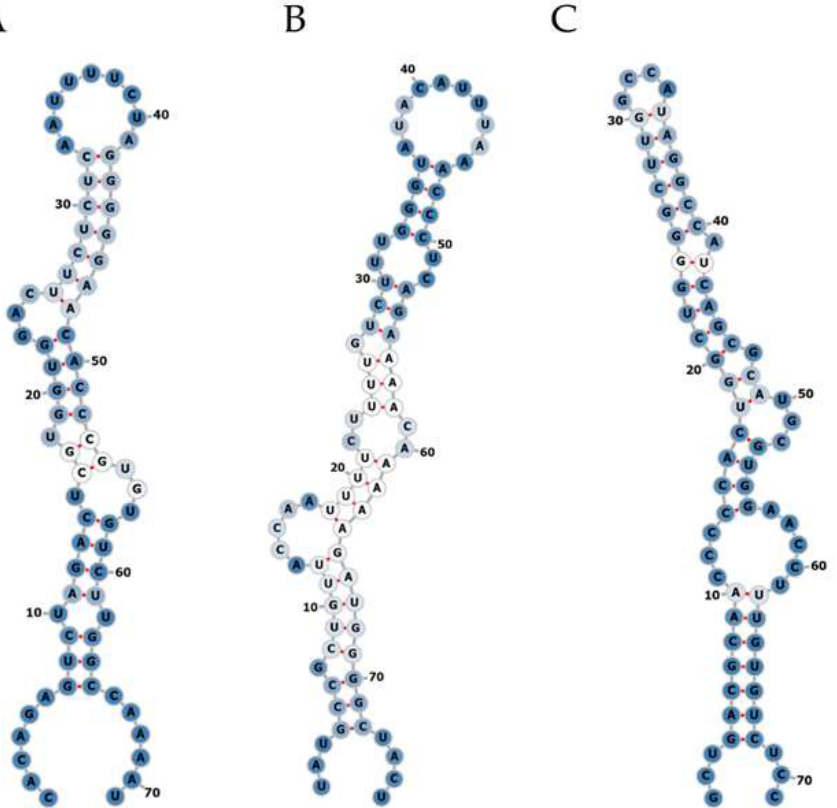
Figure 1. Secondary structure prediction of potential HBV encoded miRNAs. Small NGS of liver tissue from CHB patients revealed three pre-miRNA-like hairpin structures encoded by the HBV genome. The RNA secondary structures of the small RNAs named HBV-miR-6 ( A ), HBV-miR-7 ( B ), and HBV-miR-8 ( C ) were assessed using the mfold web server online tool. A: adenine; C: cytosine; G; guanine; U: uracil. Optimal base pairs are represented by red line between the two nucleotides. The intensity of the blue color represents the level of promiscuity in the association of any given nucleotide or helix with alternative complementary pairs (dark blue been lower and white higher). The numbers indicate the corresponding nucleotide position in the total